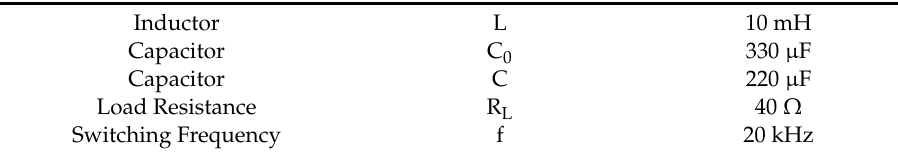
Table 3. DC-DC converter parameters.